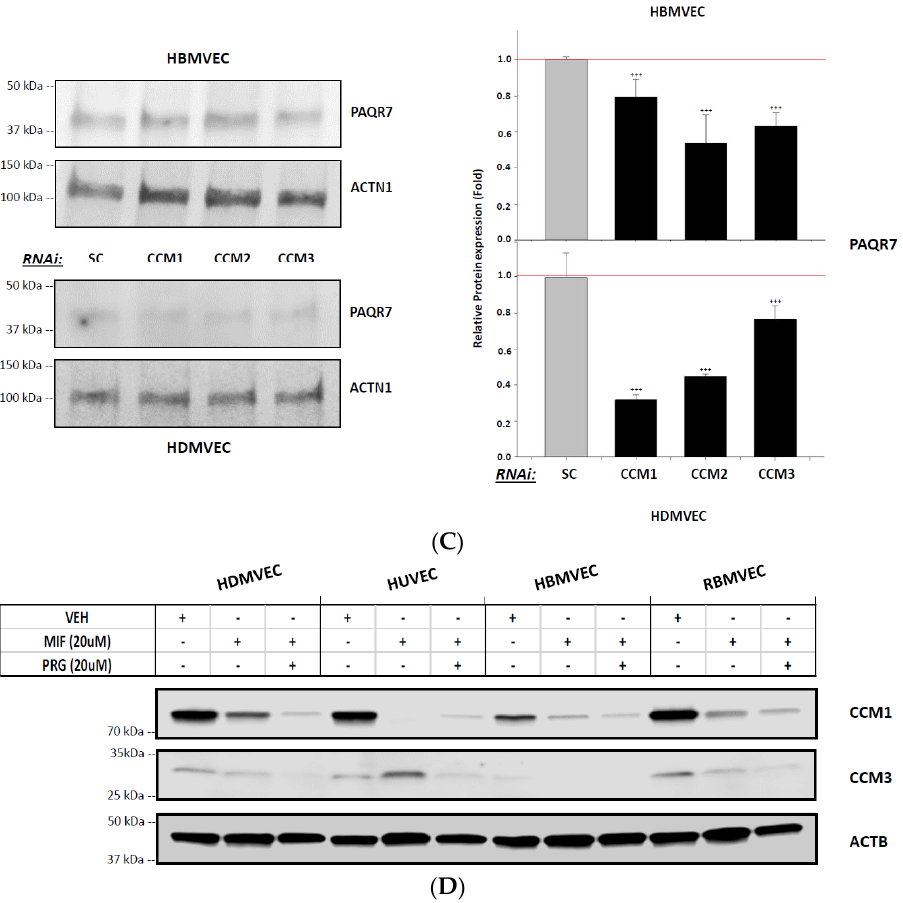
Figure 1. Relationships among key players (CCMs and mPRs) within the CmP network in nPR( − ) endothelial cells (ECs). ( A ) Silencing of CCM2 decreases the expression levels of both CCM 1/3 proteins in human brain microvascular endothelial cells (HBMVEC). ( A-1 ) After silencing all three CCMs (1, 2, or 3) for 48 h, the expression levels of all three CCM proteins were efficiently targeted and silenced; however, significantly decreased expression of both CCM1/3 proteins was observed in CCM2-KD HBMVEC cells (left upper and lower panels). The relative expression levels of CCMs (1, 2, or 3) proteins were measured through quantification of band intensities and normalized against α -actinin (ACTN1) followed by SC controls (red line), and illustrated with bar plots where light gray bars represent no change and dark gray bars display decreased relative protein levels (right panel) ( n = 3). ( A-2 ) Significantly increased RNA levels of CCM2 isoforms in both CCM1-KD and CCM3-KD in HBMVEC cells were observed. The relative transcription expression changes in CCM1, CCM3, and 5 isoforms of CCM2 in CCMs KD HBMVEC cells were measured by RT-qPCR (Fold) and illustrated in the bar plots, where light gray bars represent the relative RNA levels of CCM1, dark gray bars display relative RNA levels of CCM2 isoforms, and black bars for the relative RNA levels of CCM3 ( n = 3). ( B ) Impacts of mPR-specific actions on the RNA expression of CCM2 isoforms and mPRs in human microvascular endothelial cells. ( B-1 ) Under mPR-specific PRG actions (PRG + MIF) for 48 h, enhanced RNA expression levels of most CCM2 isoforms were observed in both human dermal microvascular endothelial cells (HDMVEC) and human brain microvascular endothelial cells (HBMVEC) cells, while increased RNA expression levels of CCM1 / 3 were only observed in HBMVECs ( n = 3). ( B-2 ) Significantly increased RNA expression of PAQR5/7/8 and PGRMC1 was observed under mPR-specific PRG actions in HBMVECs and human umbilical vein endothelial cells (HUVECs) for 48 h, while only increased RNA expression of PAQR7/8 was observed in HDMVECs, suggesting RNA expression of most mPRs can be dramatically enhanced under mPR-specific